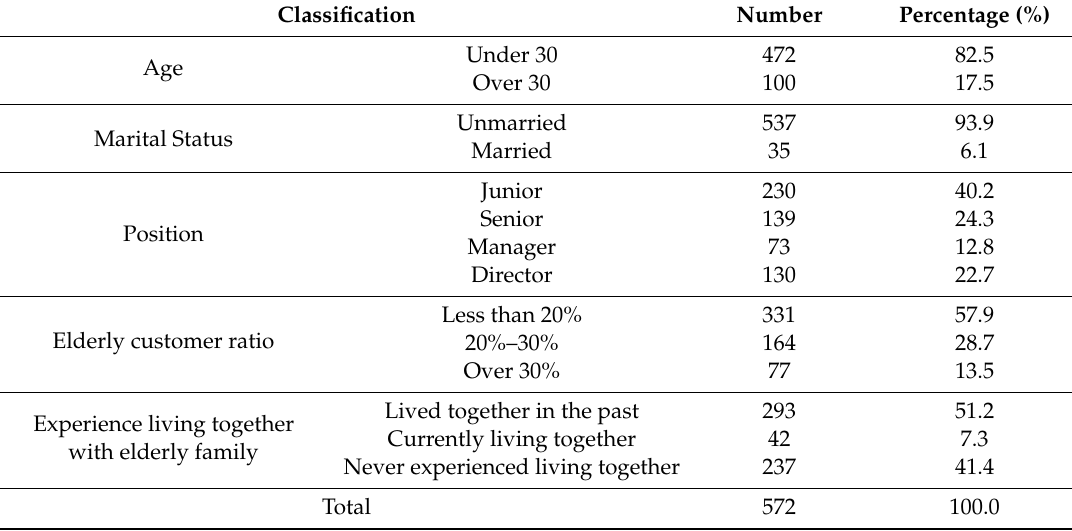
Table 1. General characteristics of survey